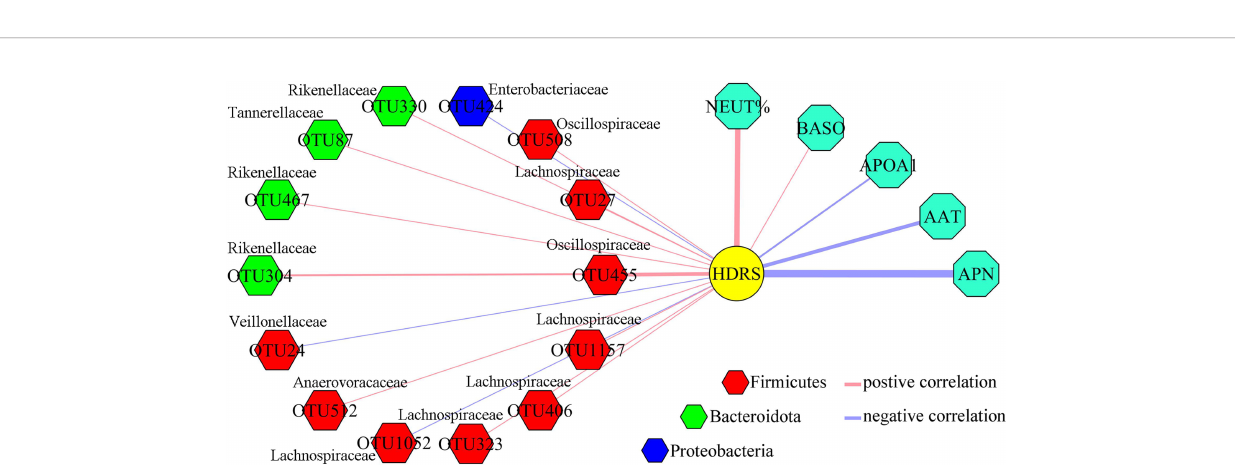
FIGURE 5 | Depression severity-related differential OTUs and differential in fl ammation-related factors. Five depression severity-related differential in fl ammation factors were identi fi ed, and most of depression severity-related differential OTUs belonged to Firmicutes.